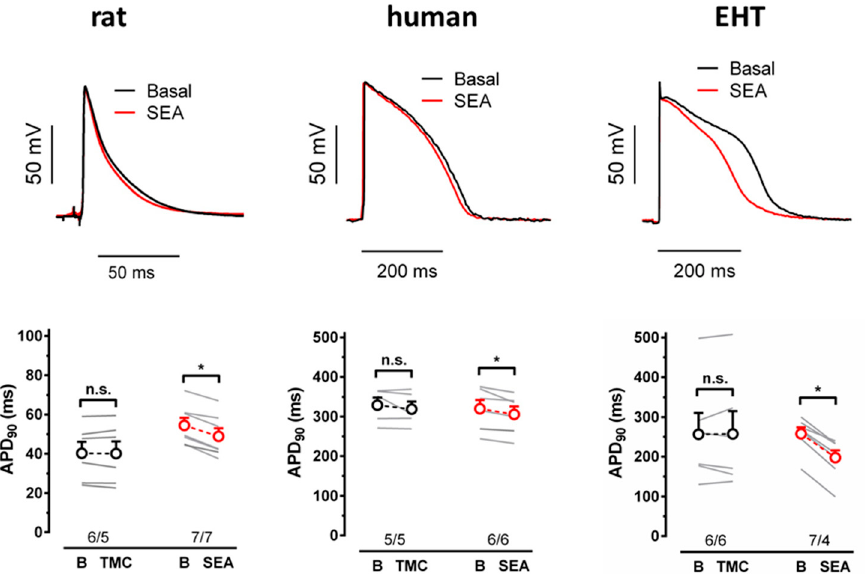
Figure 2. Action potentials in rat ventricle, human ventricle, and EHT. ( Up ) Action potential traces at pre-drug control (black trace) and after 20 min superfusion with 10 µM SEA0400 in rat ventricle, human ventricle, and EHT. ( Bottom ) Individual data points (light gray) and respective mean values ± SEM for APD 90 given as time-matched controls (TMCs) and in the presence of 10 µ M SEA0400 in rat ventricle, human ventricle, and EHT. n/n indicates the number of cells/number rats or humans and the number of cells/number of isolations for EHT, * indicates significance, n.s. indicates